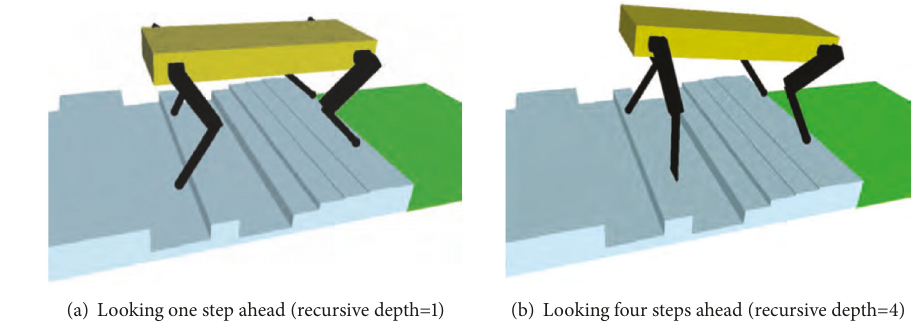
Figure 10: Different searching results by looking one and four steps ahead,